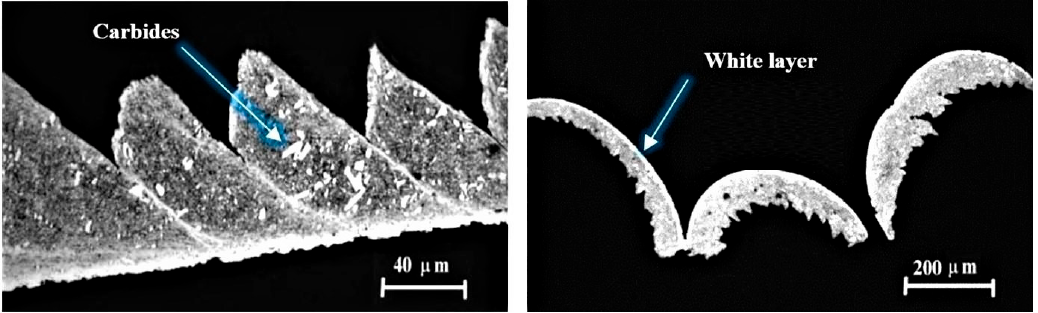
Figure 1. An example of a “white layer” on the chip surface after processing improved steel [21]. The analysis of the obtained results proved that in the case of continuous and semi- interrupted processing, greater durability was recorded for the CBN-L tool. CBN-H tools showed better properties in the case of interrupted cuts, which is a direct result of much higher strength, heat resistance and higher ductility of these materials compared to CBN-L. The authors of the cited studies concluded that the microstructure of hardened steel had the main impact on the wear of the tested PCBN tools. These conclusions coincide with those of the current work